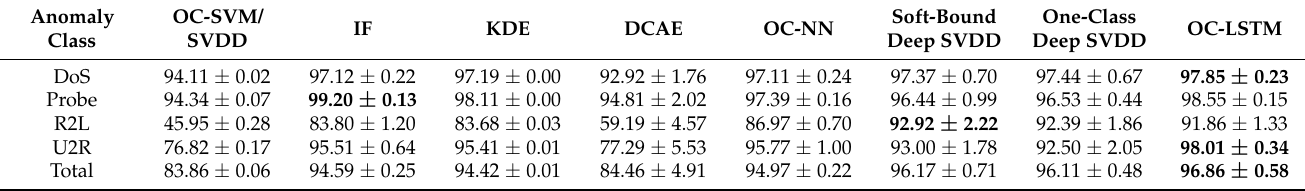
Table 2. Average AUROC values as percentages with StdDevs per method on